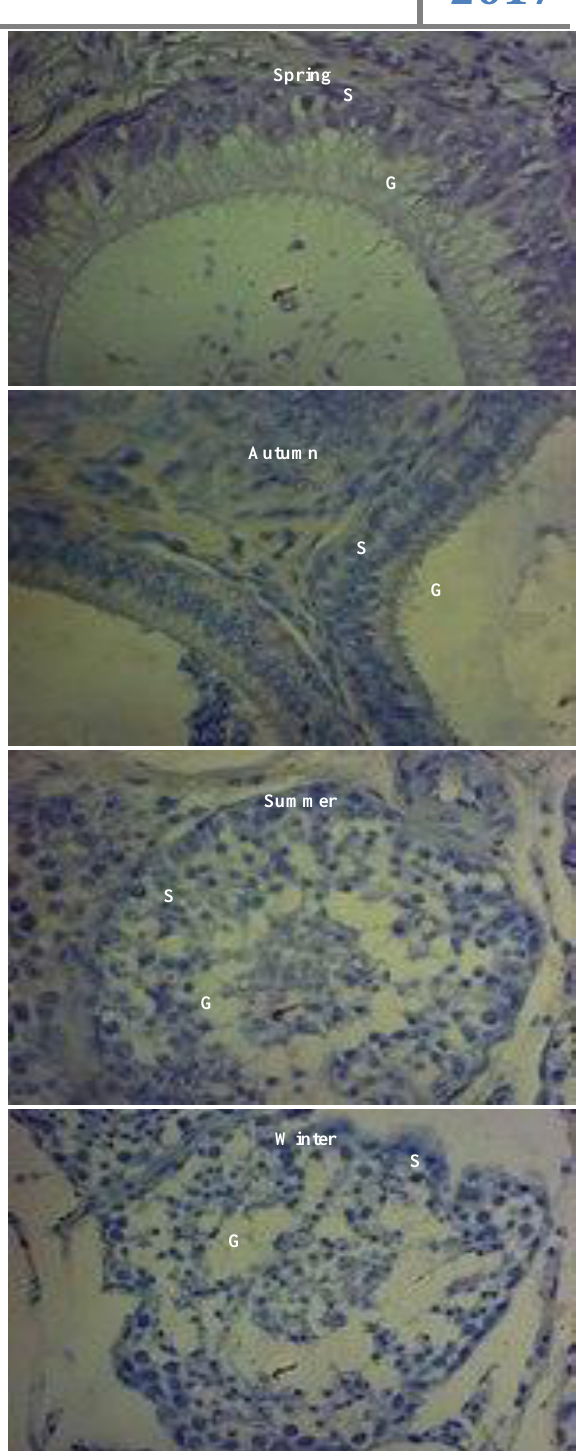
Figure, 6: Immunolocalization of Sertoli cells (S) and germinal epithelium (G) during different seasons.